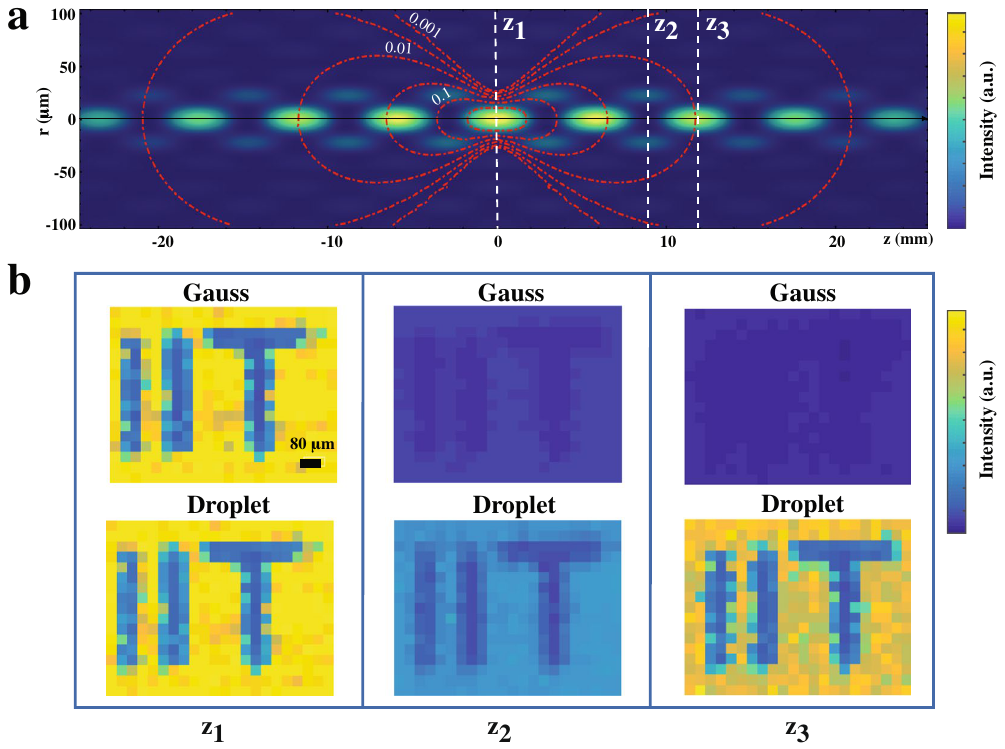
Figure 5. Top view of the droplet intensity distribution and contour (red dashed) lines of a focused Gaussian beam ( a ). A set of images were acquired at three different z-positions along the illumination axis ( b ). Images acquired at the focal plane ( z = z 1 ) with both Gauss and droplet illuminations exhibited equal contrast. However, as the sample was axially displaced from the focal plane, the contrast given by the Gaussian illumination rapidly dropped to zero, whereas the droplet illumination gave a decrease ( z = z 2 ) followed by a 10x-increase ( z = z 3 ) in the image contrast, the manifestation of the droplet